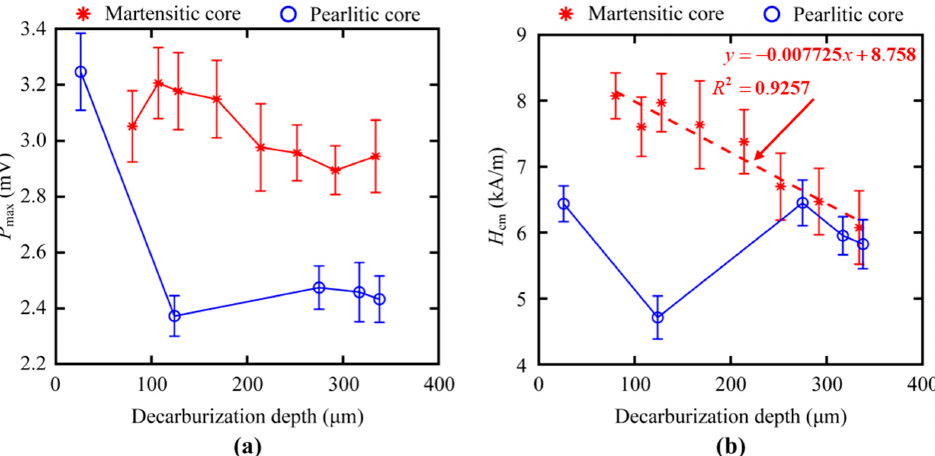
Figure 9. Dependency of features ( a ) P max and ( b ) H cm on the surface decarburization depths for all samples with martensitic and pearlitic cores. The relationship between the H cm and depth in samples with martensitic core and pearlite is drawn in Figure 9b. Ferrite has smaller coercivity than pearlite and martensite [18]. Consequently, the H cm value representing the coercive field (red line in Figure 9b) decreased with the increase in the decarburization depth of the samples with a martensitic core. This can also be explained by the relationship between the coercivity field and me- chanical hardness. When the martensite volume fraction decreases with the increases in the decarburization depth of the martensitic core samples, the coercive field decreases with the decrease in the mechanical hardness [19]. In addition, the H cm (blue line in Figure 9b) obtained from the samples with pearlitic core showed a similar decrease with the